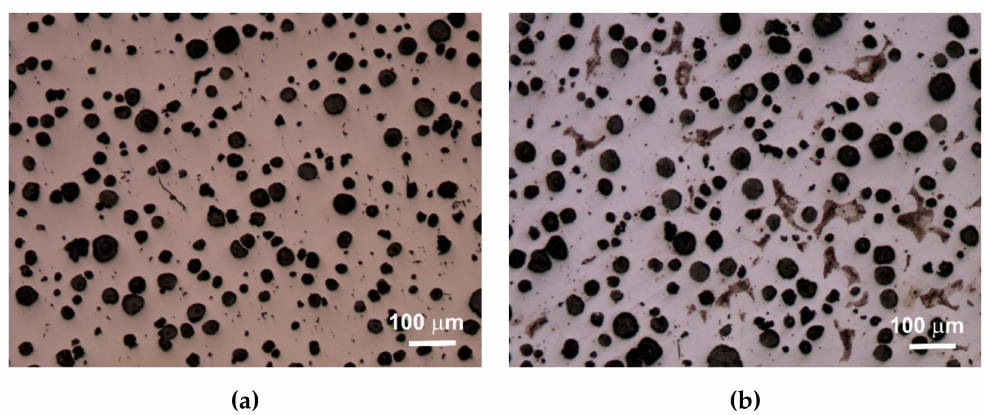
Figure 4. Microstructure of sample 5 non-etched ( a ) and etched ( b ).